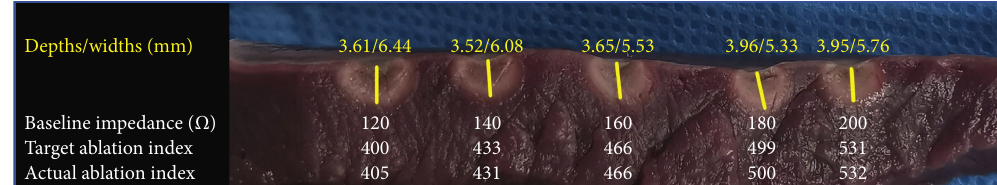
Figure 4: The lesion depths, baseline impedance, and AI values in formula-guided ablation in the common AI